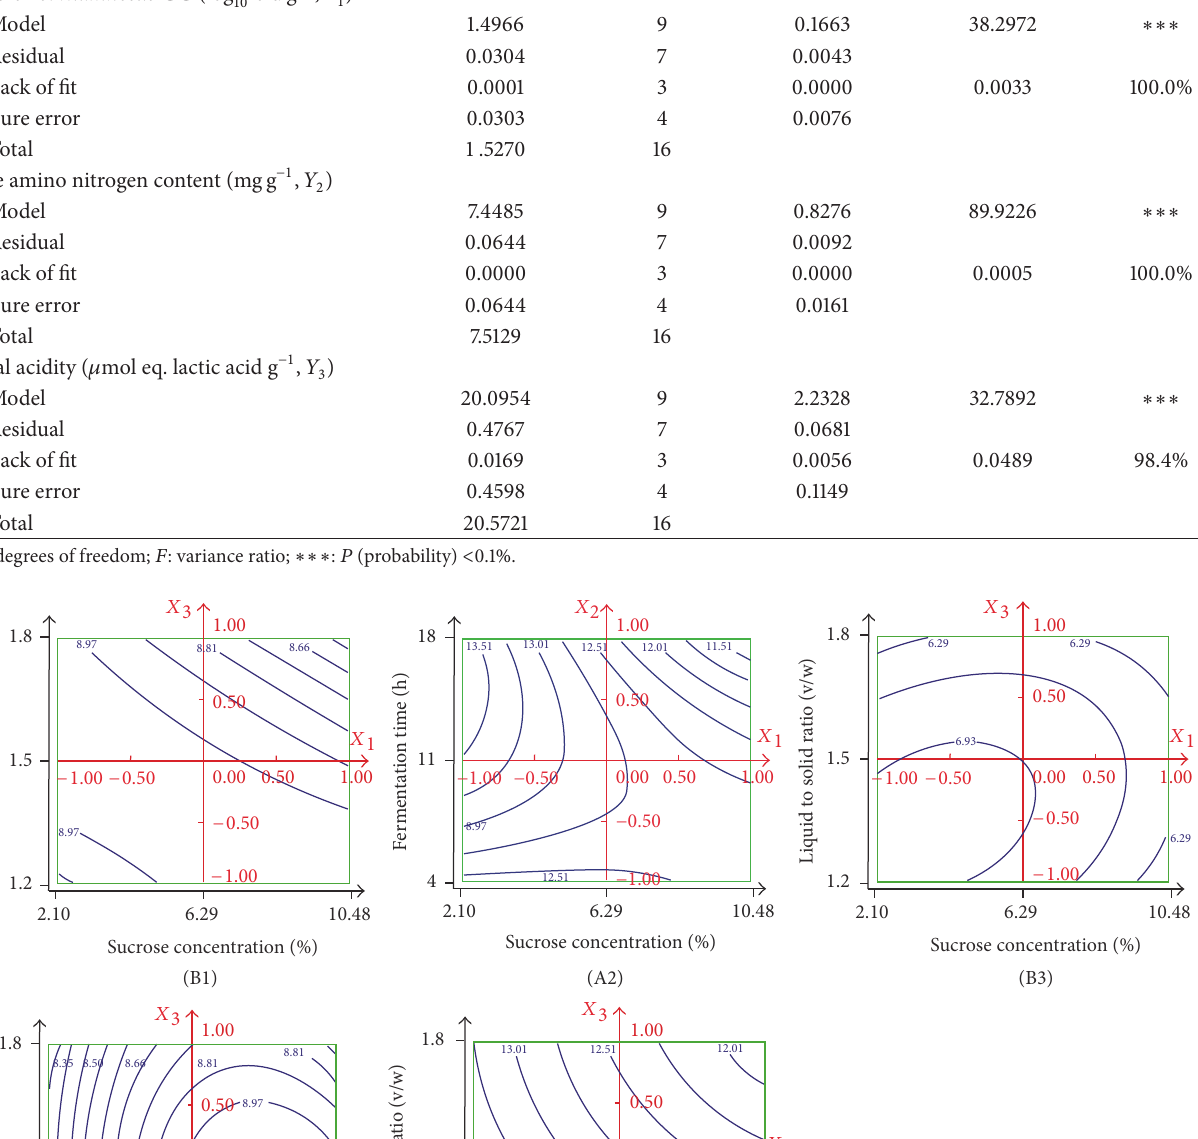
−1 , 11h, 𝑋 𝑋 1 , 2 , and 3 are 6.29 g (100gDM)